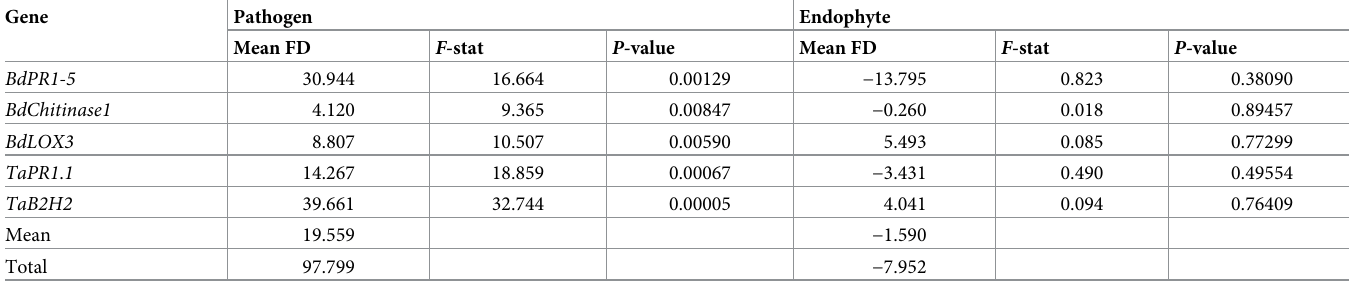
Table 3. Expression-level differences for chosen genes in leaves of Brachypodium distachyon (Bd) and wheat plants. Gene expression was detected as fold difference (FD) between inoculated (by pathogen or endophyte) and non-inoculated plants (mock). Gene